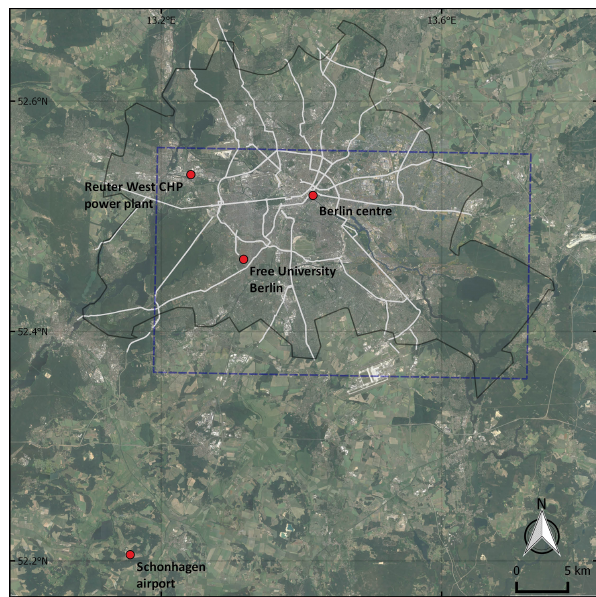
Figure 1. Overview map, showing the location of the Berlin city centre, the power plant Reuter West, the Free University Berlin, and the Schönhagen airport. The flight plan is indicated by the blue dashed rectangle. Key roads are shown in white and the city border in black (Google,